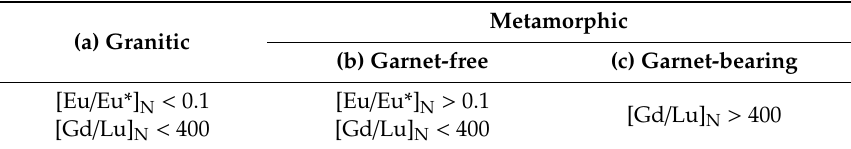
Figure 4. Variations in chemical compositions of monazites from various rock types plotted with the actual rock type. ( a ) Plot of Nd versus Eu and ( b ) plot of [Gd / Lu] N versus [Eu / Eu*] N . Plot of [Gd / Lu] N versus [Eu / Eu*] N shows a clearer clustering than that of Nd versus Eu. Table 1. Geochemical criteria for monazite source rock type based on the Eu anomaly and relative depletion of heavy-to-middle rare earth